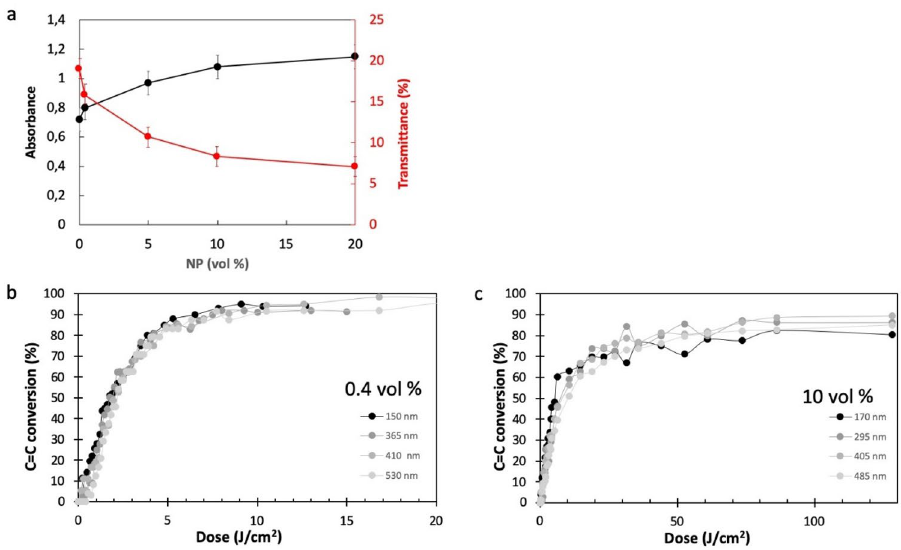
Figure 4. ( a ) Absorbance (black dots) and transmittance (red dots) at 210 nm of nanocomposite films (thickness: 100 nm) for different concentrations of NPs measured by UV–vis spectroscopy. ( b ) and ( c ) Conversion of the C=C band plotted as a function of the irradiation time for respectively 0.4 vol% and 10 vol% of CoFe 2 O 4 MNPs, and for several film thicknesses in the range 150–530 nm. Irradiation was carried out with LC8 lamp (70 mW/cm 2 ) and conversion was calculated from the decrease of the 1638 cm −1 band (molar ratio Si/ Ti :